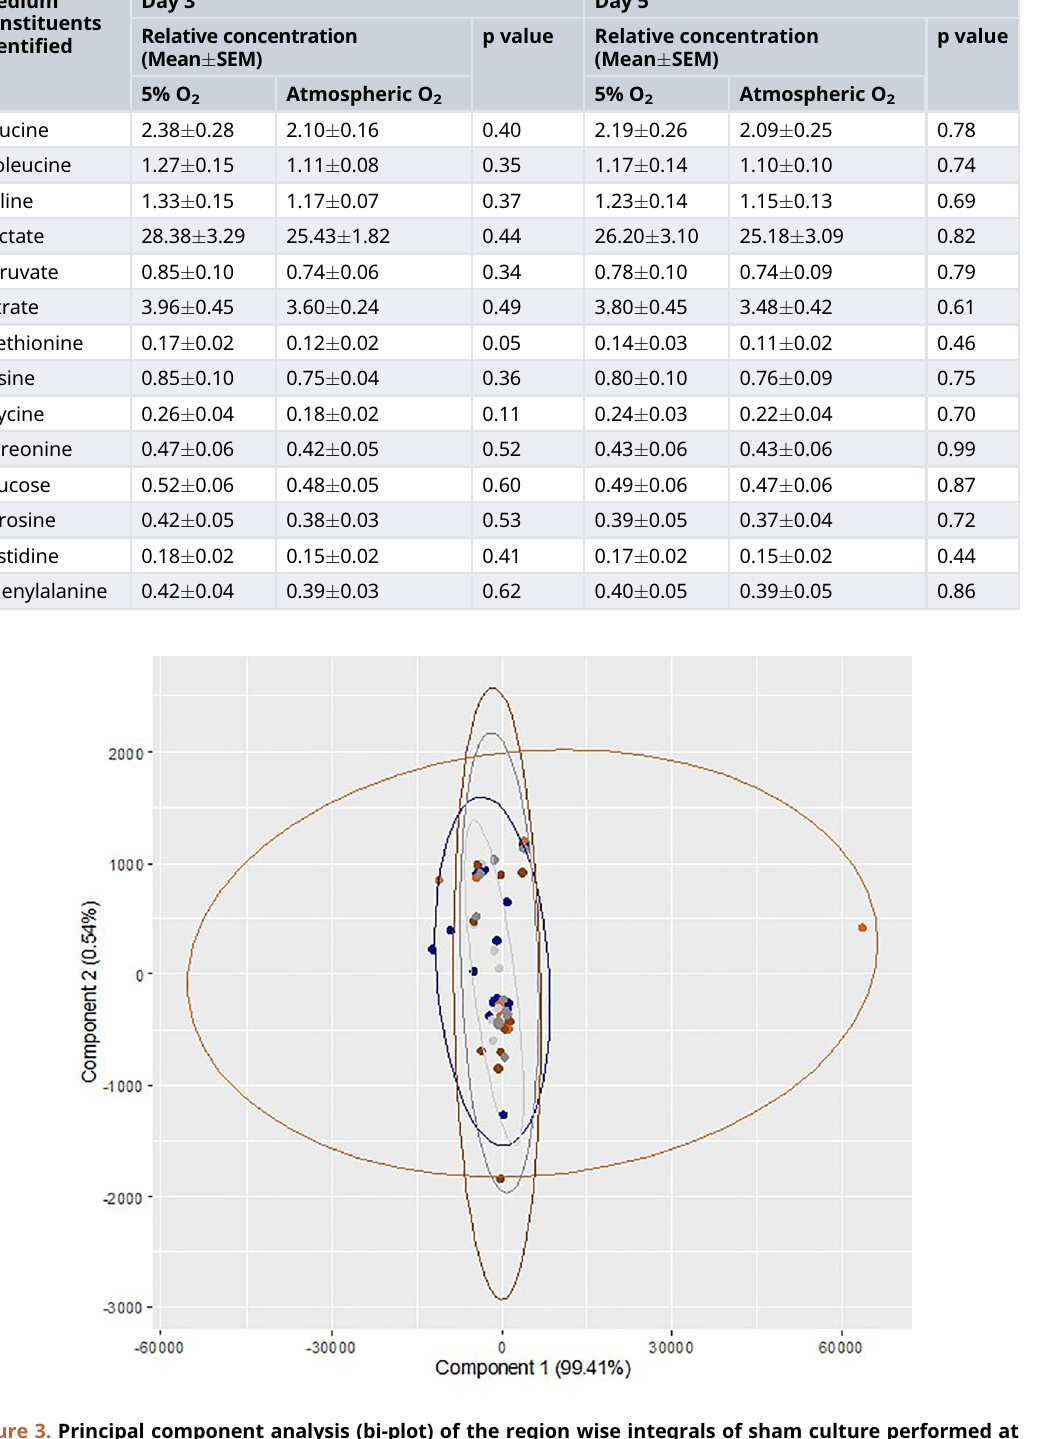
Figure 3. Principal component analysis (bi-plot) of the region wise integrals of sham culture performed at humidified/atmospheric oxygen and dry/physiologic oxygen level and collected at different time interval (0 h, 72 h and 120 h). Blue color ( ) represents sample collected at 0h (baseline control) and light ash color ( ) represents the sham culture performed at humidified/atmospheric O 2 level and collected at 72 h, whereas orange color ( ) represents the sham culture performed at dry/physiological O 2 level and collected at 72 h. Dark grey color ( ) represents the sham culture performed at humidified/atmospheric O 2 level and collected at 120 h and dark chocolate color ( ) represents the sham culture performed at 5 dry/physiological O 2 level and collected at 120